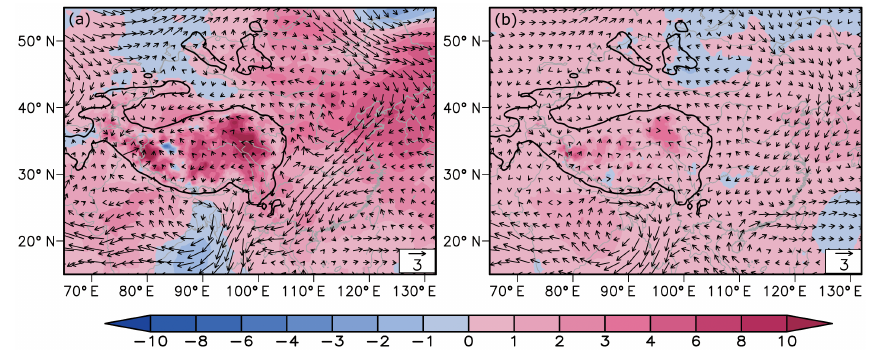
Figure 11. Simulated difference in atmospheric circulation at 850hPa (vector, ms − 1 ) and geopotential height at 600hPa (shaded, m) in summer between CON and SEN in (a) heavy and (b) light dust years.